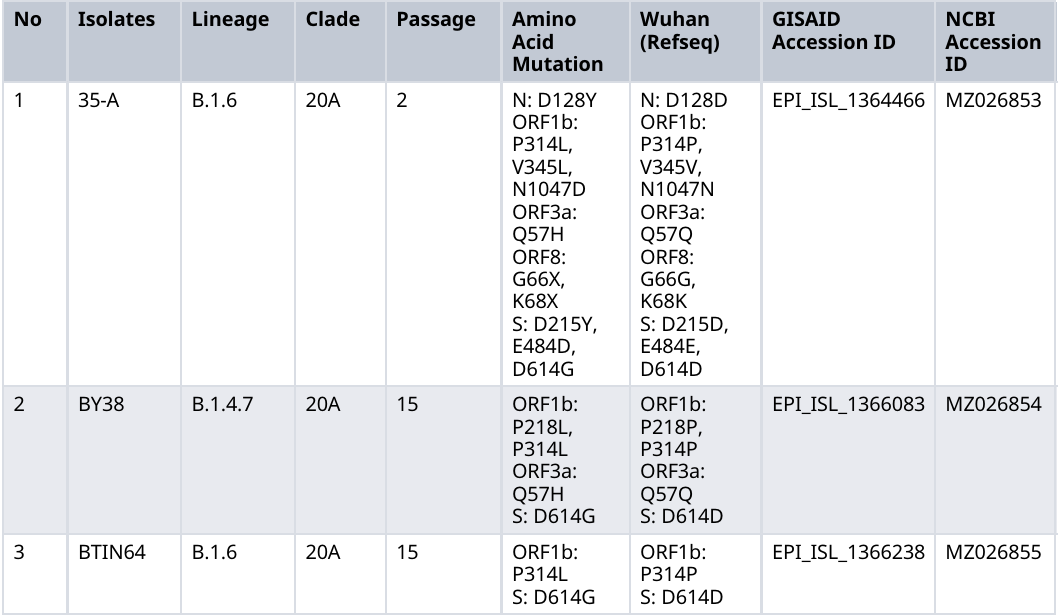
Table 1. Isolate ’ s lineage, clade, passage, amino acid mutation, reference sequence, and accession number.